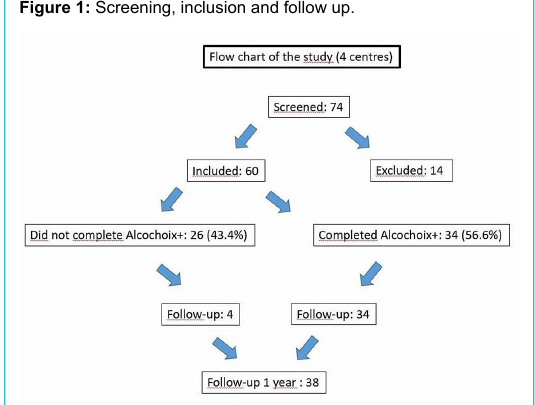
Figure 1: Screening, inclusion and follow